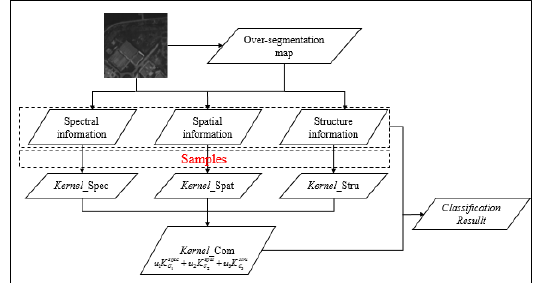
Figure 4. The panchromatic QuickBird image (a) and the ground truth map (b).